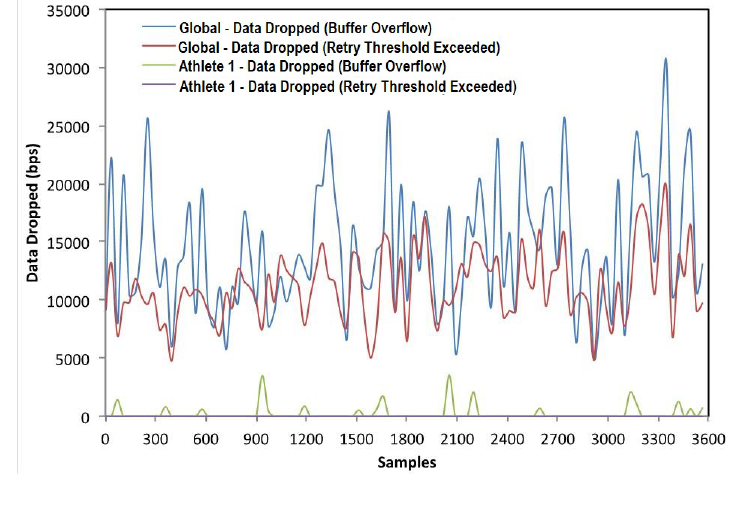
Figure 8. Data dropped by buffer overflow and retry threshold